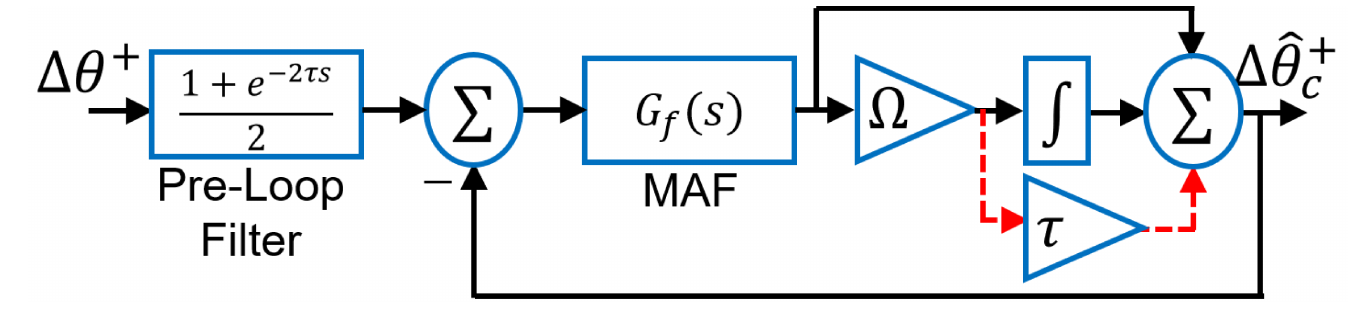
Fig 2. Small-signal model of the proposed technique.